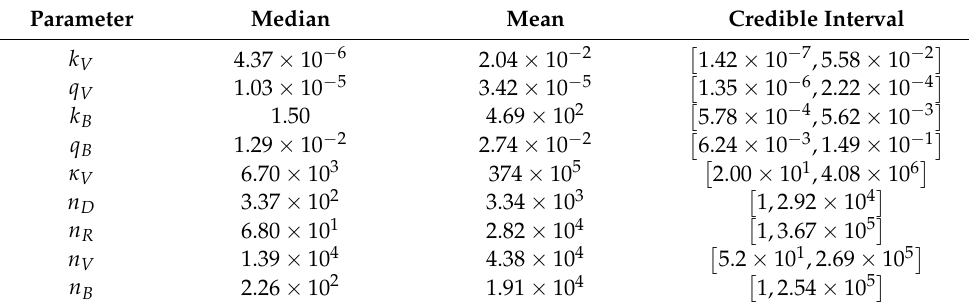
Table 4. Summary statistics for each accepted parameter value sets from model 1. Mean, median and a 95% credible interval are summarised in the